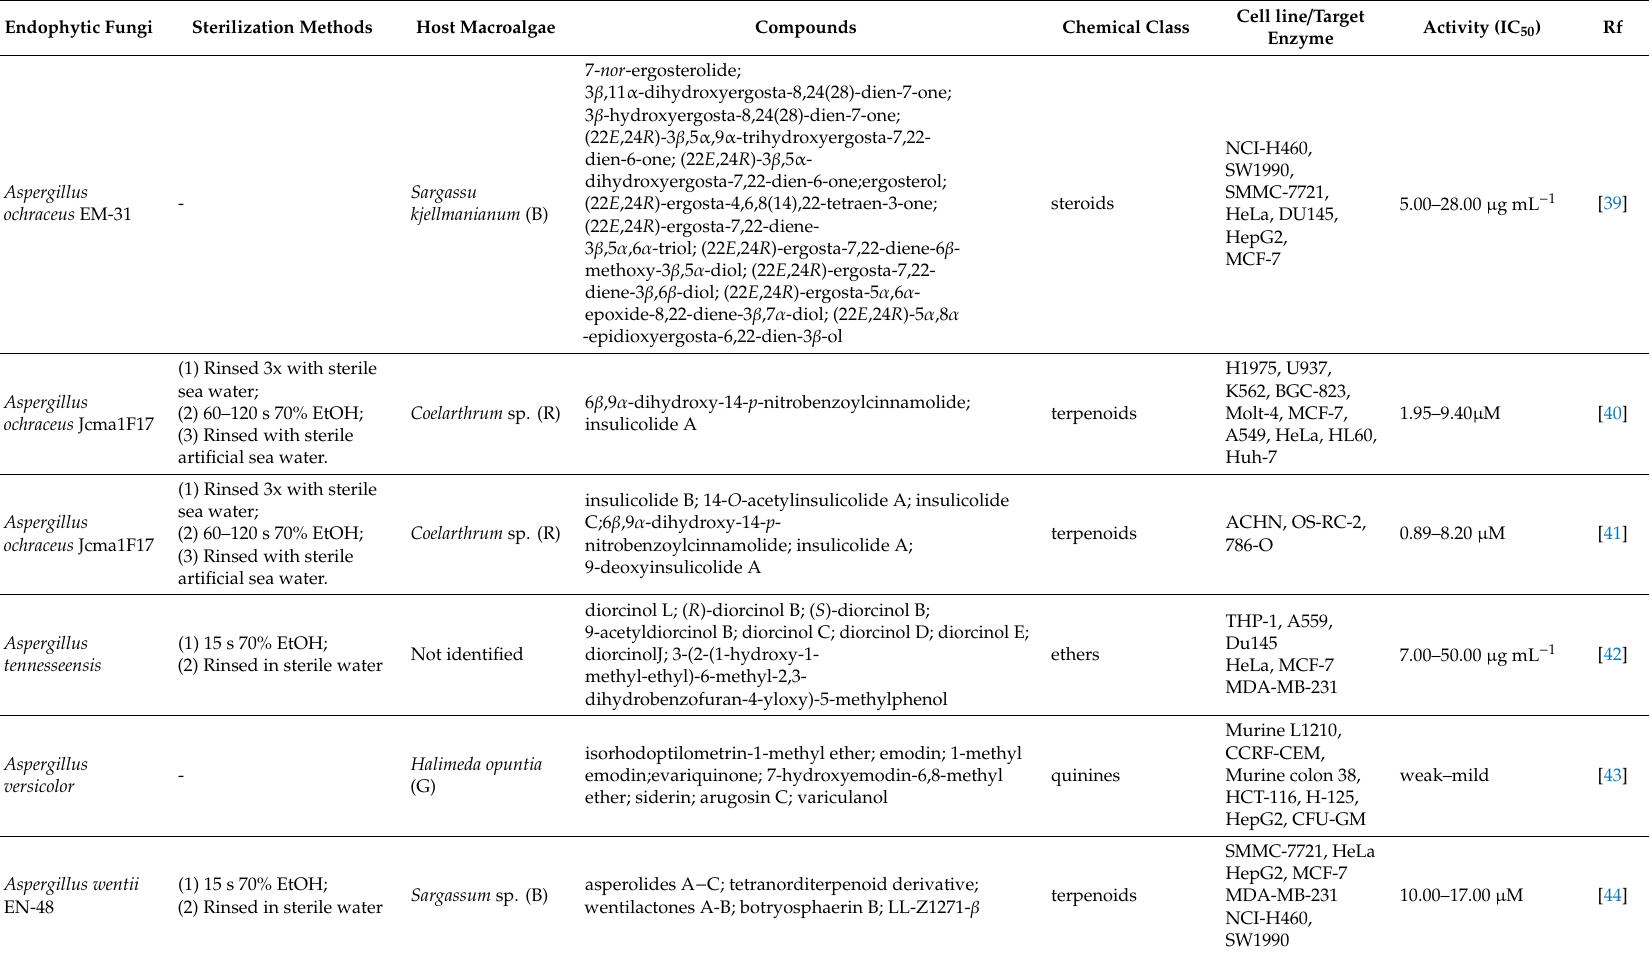
Table 1. Antitumor compounds isolated from seaweed derived-endophytic fungi literature from 2009 to the present. (B) = Brown macroalgae, (G) = Green macroalgae, (R) = Red macroalgae and Rf. =